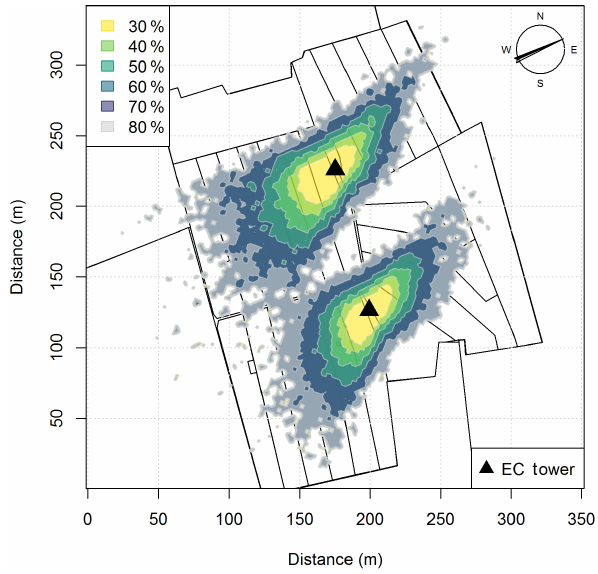
Figure 4. Footprint climatology for both EC towers averaged for the time period between 15 March and 15 November 2016. The legend values indicate the percentage of the total footprint